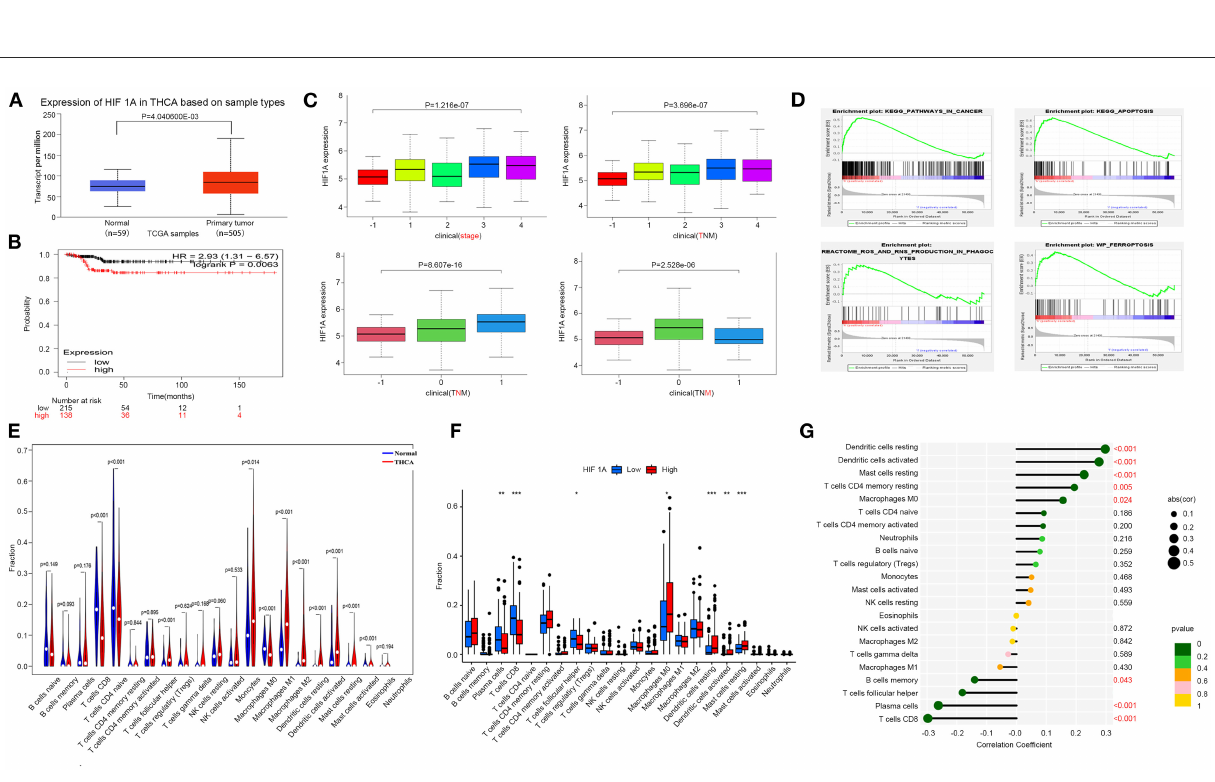
FIGURE5 Increased expression of HIF1A promotes the progression of THCA. (A) The HIF1A expression difference in the tumor group vs. the normal group. (B) Kaplan-Meier plot illustrating the influence of HIF1A expression level on THCA survival. (C) HIF1A and TNM staging of thyroid cancer. (D) GSEA analysis of THCA pathway differences (FDR<0.25 is deemed significant). (E–G) Correlation of THCA and HIF1A with immunological infiltration. * P < 0.05, ** P < 0.01, *** P <